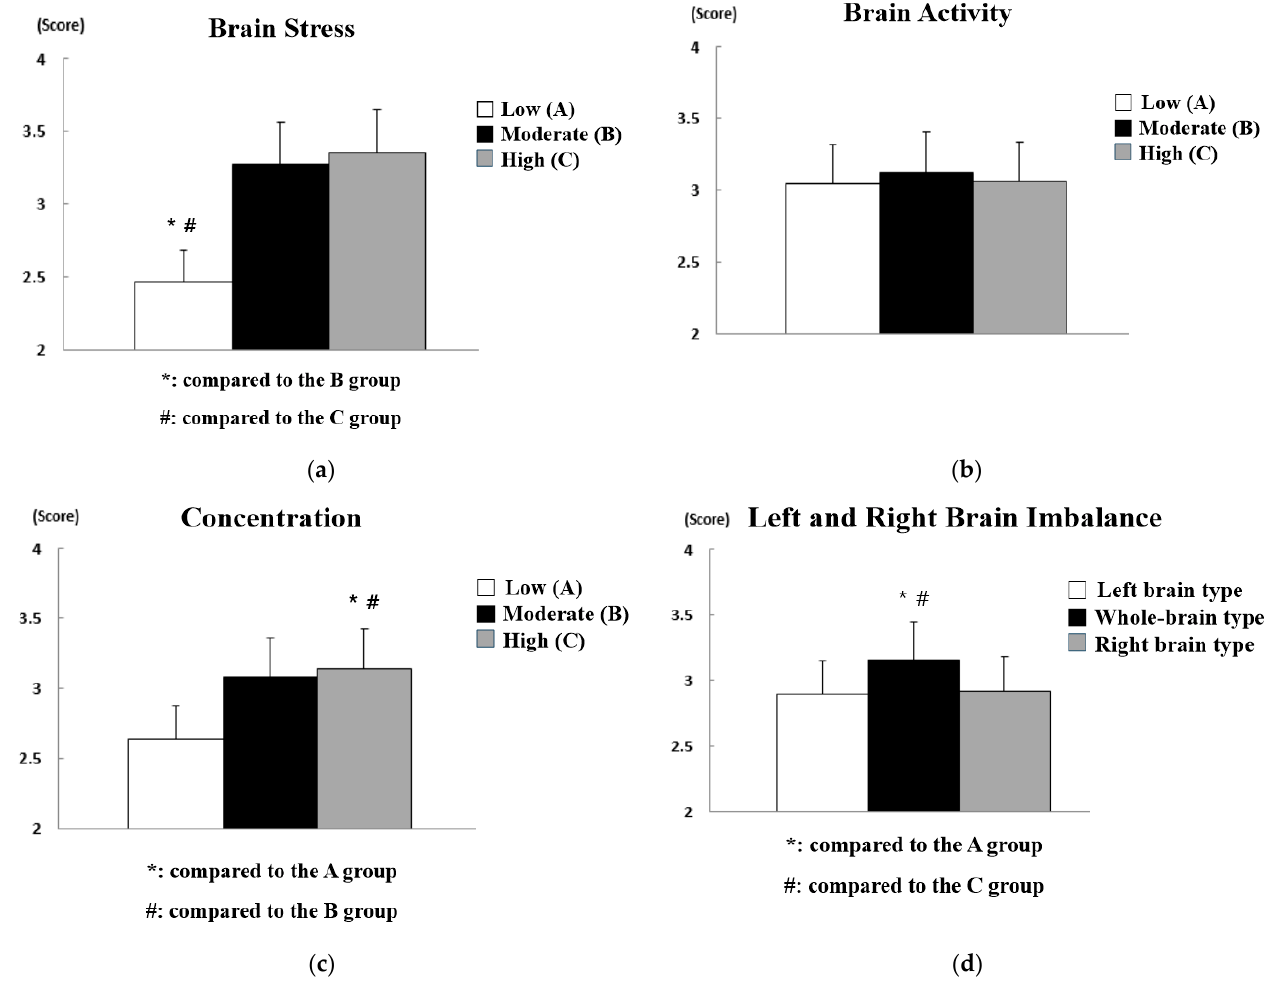
Figure 6. Analysis of differences in safety consciousness according to brain wave data: ( a ) effect of brain stress; ( b ) effect of brain activity; ( c ) effect of concentration; ( d ) effect of left and right brain imbalance. Table 5. Statistical analysis results for differences in safety consciousness according to brain wave data.